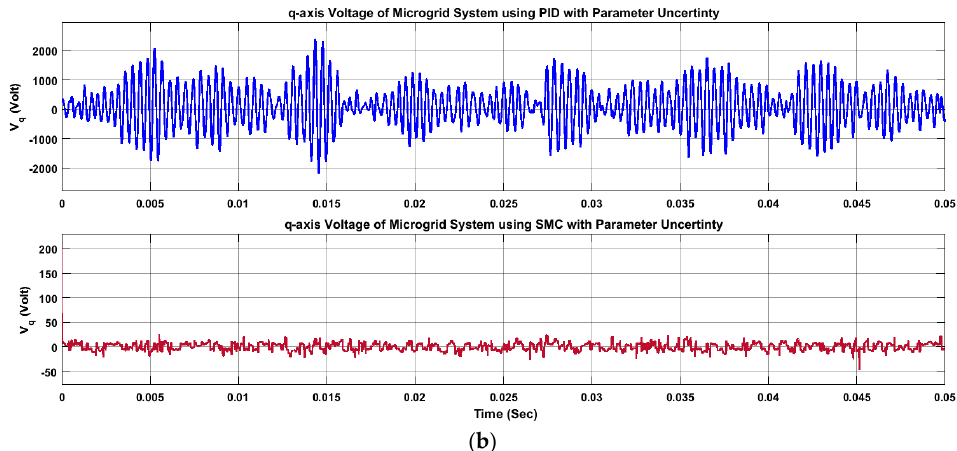
Figure 12. Performance comparison between PID (blue colored) and SMC (red colored) in the case of ( a ) real axis output voltage ( V d ) and ( b ) reactive axis output voltage ( V q ) considering parametric uncertainties.